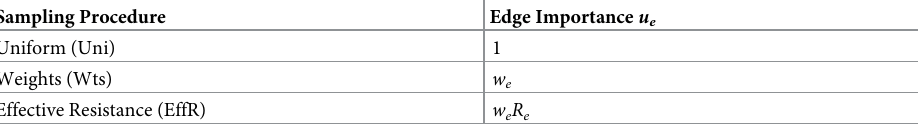
Table 1. Random Sampling